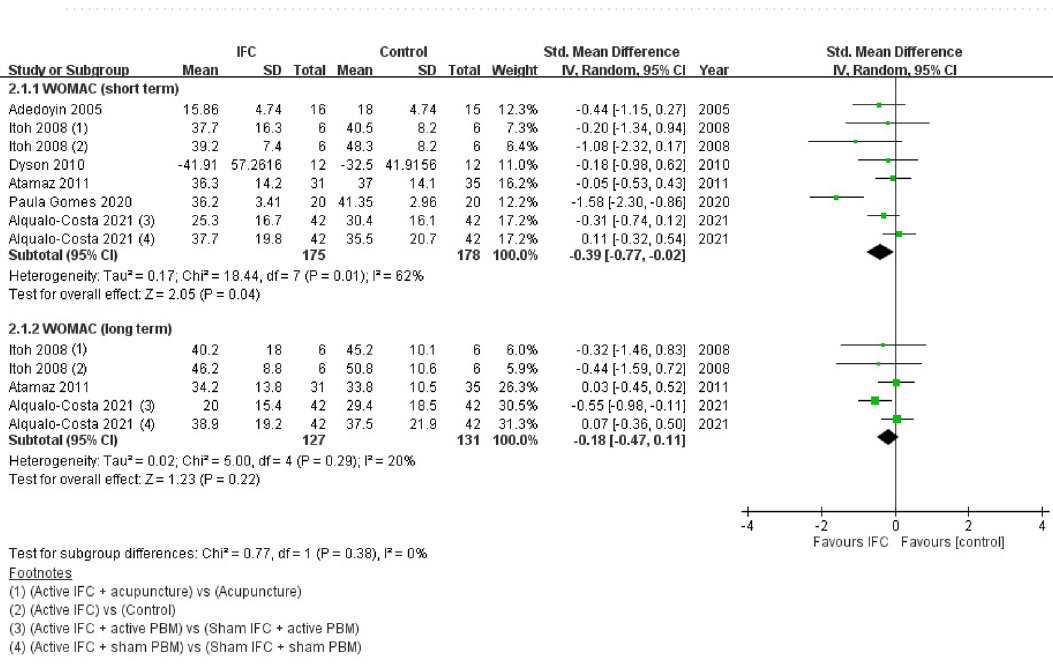
Figure 3. WOMAC scores of IFC and control groups after sensitivity analysis. WOMAC Western Ontario and McMaster Universities Osteoarthritis Index, IFC interferential current therapy, PBM photobiomodulation, 95% CI 95% confidence